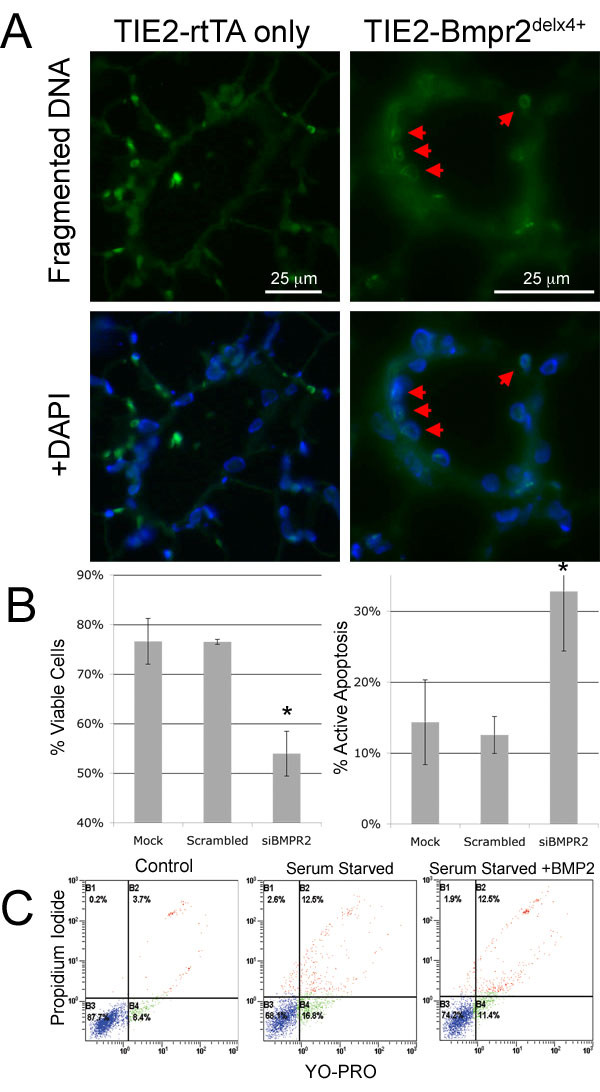
Bmpr2delx4+ mutation predisposes to increased PMVEC apoptosis. (A) Immunofluorescence of fragmented DNA labeled with fluorescein; red arrows point to positive nuclei (B) PMVEC from control animals show increased apoptosis when inhibited with siRNA directed to BMPR2 * = p < .05 by ANOVA. (C) Representative scatter plots indicating exogenous BMP2 reduces apoptosis in serum starved condition.